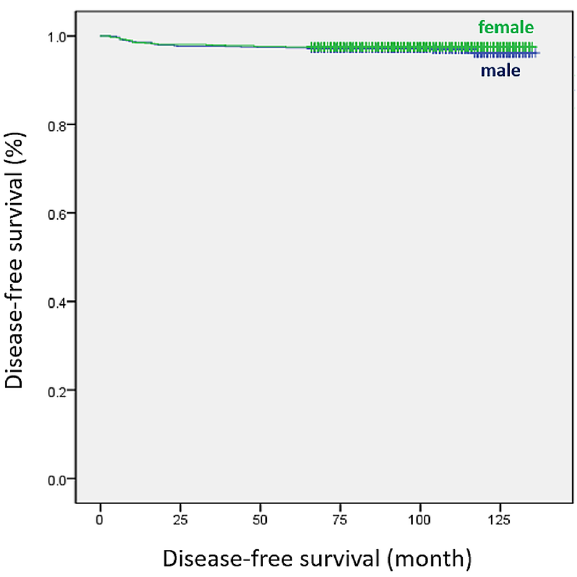
Figure 2. Disease-free survival curves of female and male groups after propensity score matching (log-rank p =